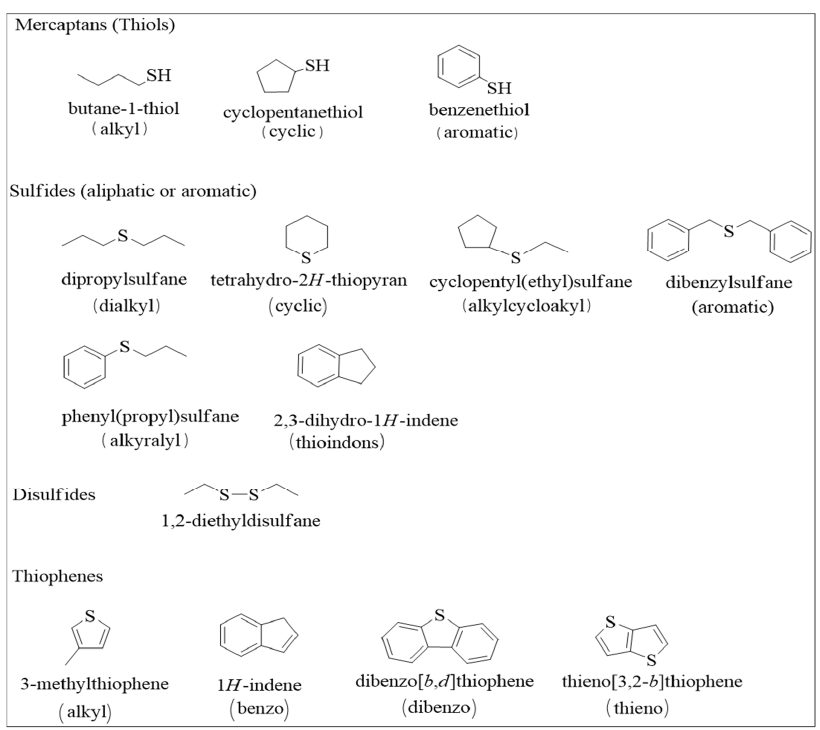
Figure 2. Different types of sulfur ‐ containing organic compounds identified in crude oil.